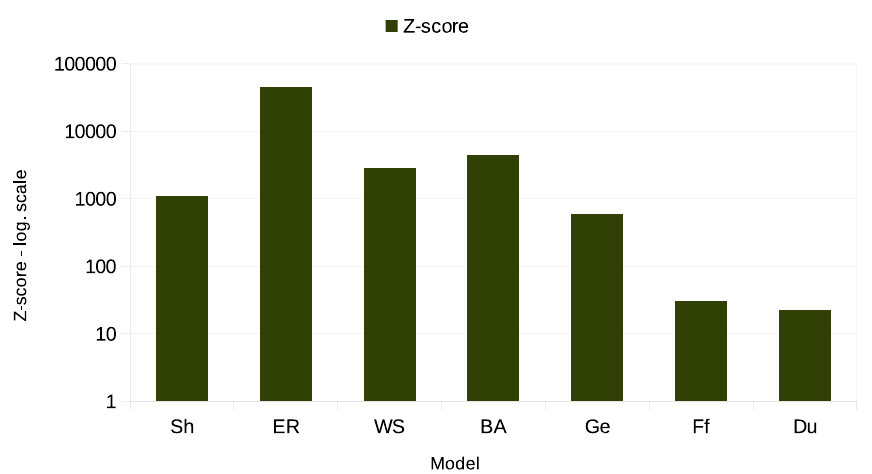
Figure 11. Z-scores for the feed forward loop on Mus musculus with no labels according to Shuffling (Sh), Erdos-Renyi (ER), Watts-Strogatz (WS), Barabasi-Albert (BA), Geometric (Ge), Forest Fire (Ff) and Duplication (Du)